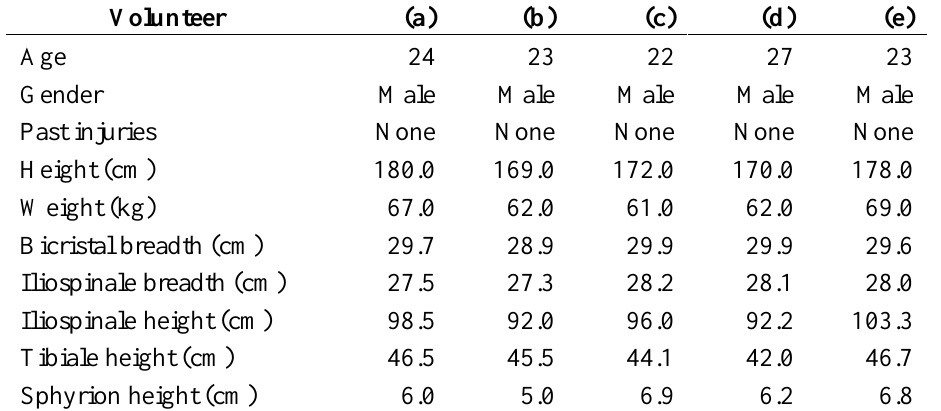
Table 1. Information of the volunteers. Age, gender, past injuries, height, weight, bicristal breadth, iliospinale breadth, iliospinale height, tibiale height and sphyrion height are listed.